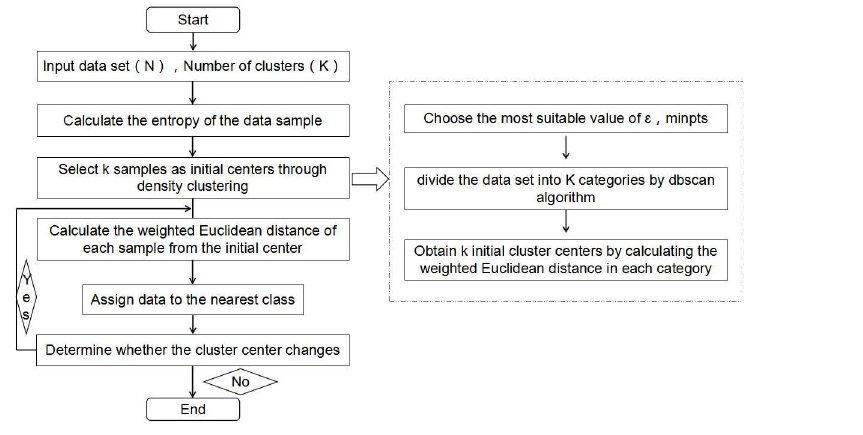
Fig 1. Improved k-means algorithm flow